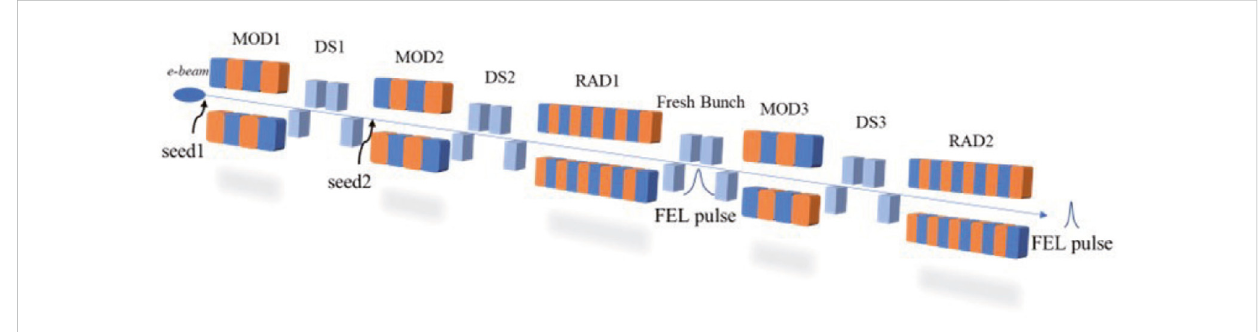
FIGURE 1 Schematic layout of the